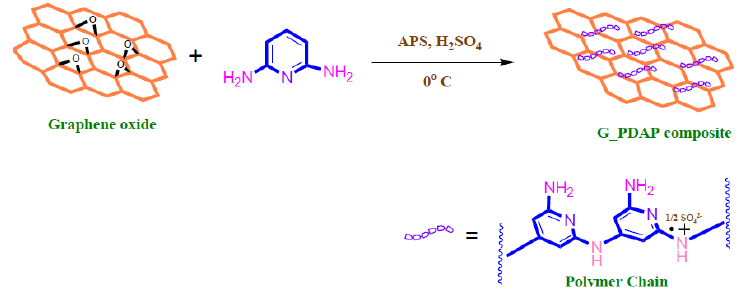
Figure 13. Synthesis process of G-PDAP composite (Reproduced or adapted from ref. [37], with permission from Elsevier, 2020).